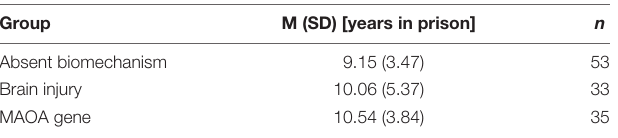
TABLE 2 | Duration of sentencing depending on the group of respondents (M = mean, SD = standard deviation, n = number of students in the group).